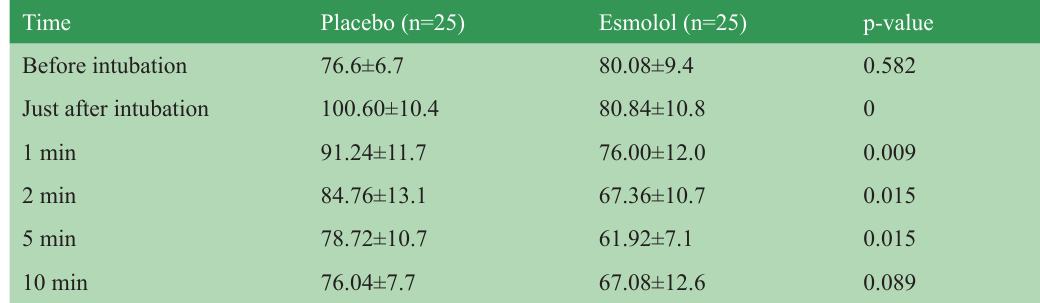
Table 6: Mean diastolic blood pressure (mmHg) between placebo and lidocaine groups Time Placebo (n=25) Lidocaine (n=25) p-value Before intubation